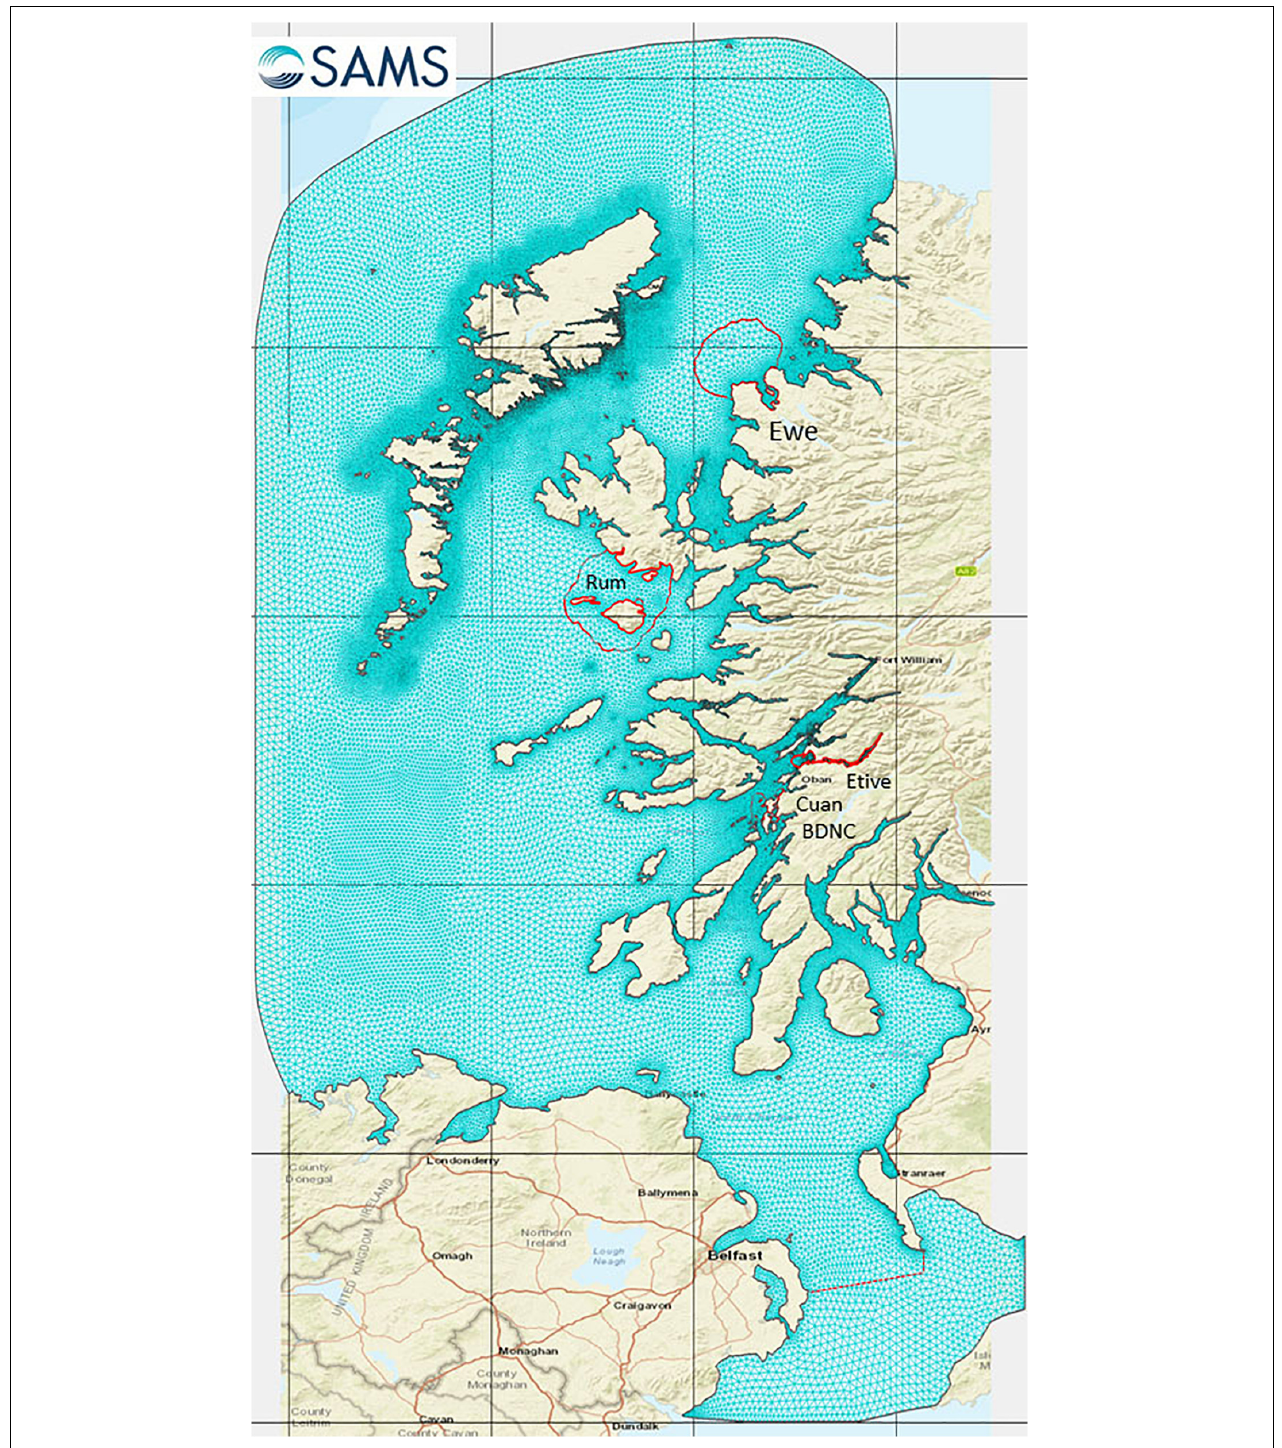
FIGURE 6 | The West Scotland Coastal Ocean Modelling System (WeStCOMS-FVCOM) model domain.